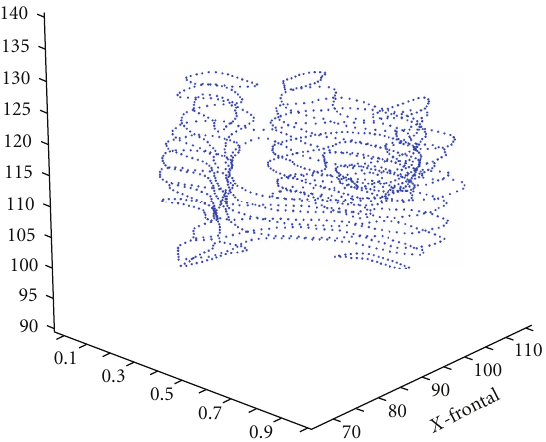
Figure 2: Assembling of cervical vertebrae from previously defined contours.